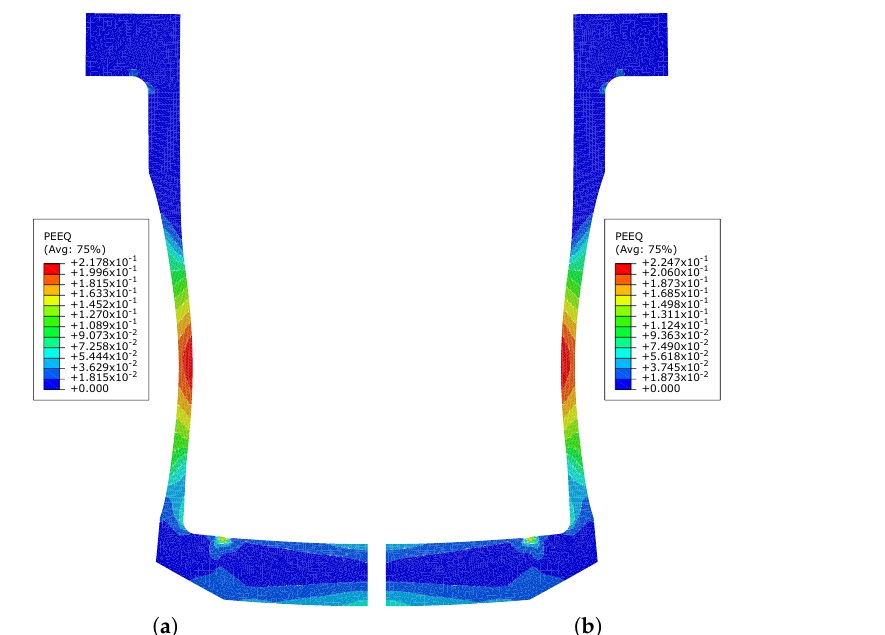
Figure 15. Equivalent plastic strain contour-plots of the complete model and simplified model for Dynamic tensile test. ( a ) Equivalent plastic strain contour-plot of the complete model; ( b ) Equivalent plastic strain contour-plot of the simplified model.